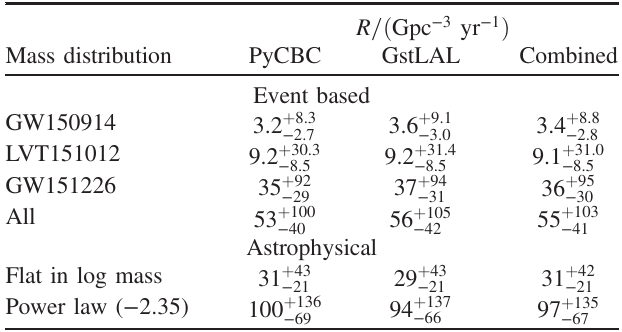
TABLE II. Rates of BBH mergers based on populations with masses matching the observed events, and astrophysically mo- tivated mass distributions. Rates inferred from the PyCBC and GstLAL analyses independently as well as combined rates are shown. The table shows median values with 90% credible